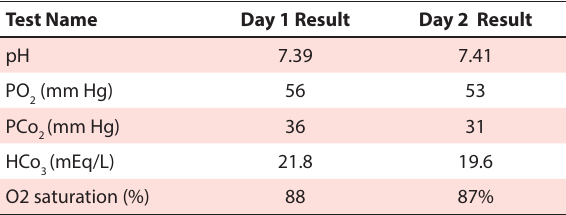
Table 1. Laboratory data: ABG test at admission and on the second day of hospitalization